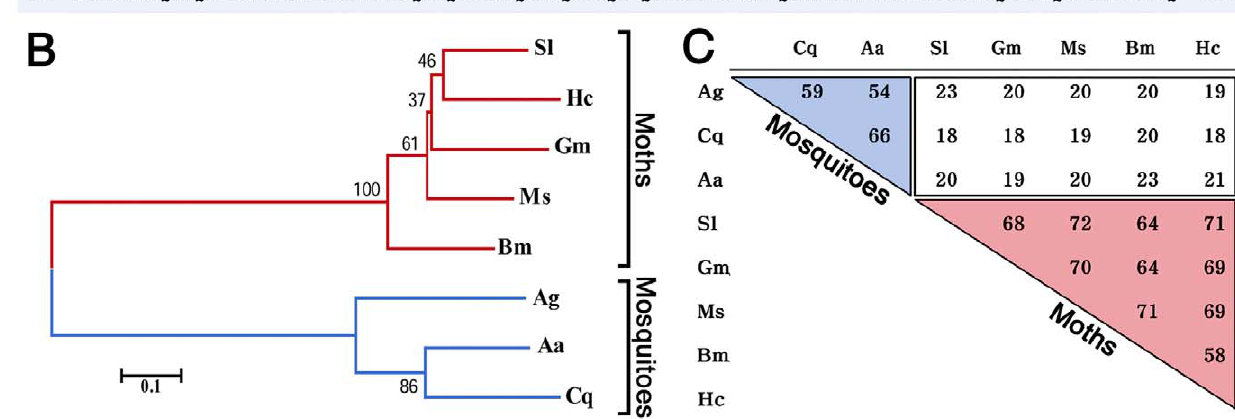
Figure 2. Sequence alignment, phylogeny, and sequence homology of insect members of the ApoLP-III family. (A) Sequence alignment of ApoLp-III sequences from Anopheles gambiae (Ag), Culex quinquefasciatus (Cq), Aedes albopictus (Aa), Spodoptera litura (Sl), Galleria mellonella (Gm), Manduca sexta (Ms), Bombyx mori (Bm), and Hyphantria cunea (Hc). Blue box ( ) indicates highly conserved region; red arrows ( ) denote insertions in the sequence of mosquito members of the gene family. (B) Phylogenetic tree based on sequence alignment of the deduced amino acid sequence of members of the ApoLp-III family from different insect species. Mosquito sequences are indicated in blue and those from moths in red. (C) Sequence identity among ApoLp-IIIs from insects. The blue triangle ( ) indicates identities among mosquitoes and the red triangle ( ) among moths. Notice the low level of sequence conservation between mosquitoes and moths (white area).